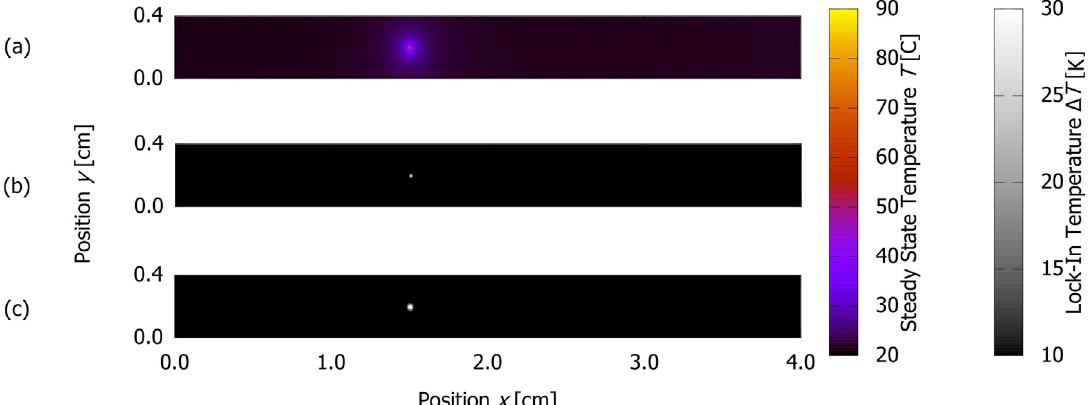
Fig. 2. Results of lock-in measurements using the updated setup. (a) Steady state thermographic image; (b) Lock-in image of a sample when only the modulated laser is applied; (c) Lock-in image of the sample when the modulated laser with a DC reversed voltage are applied